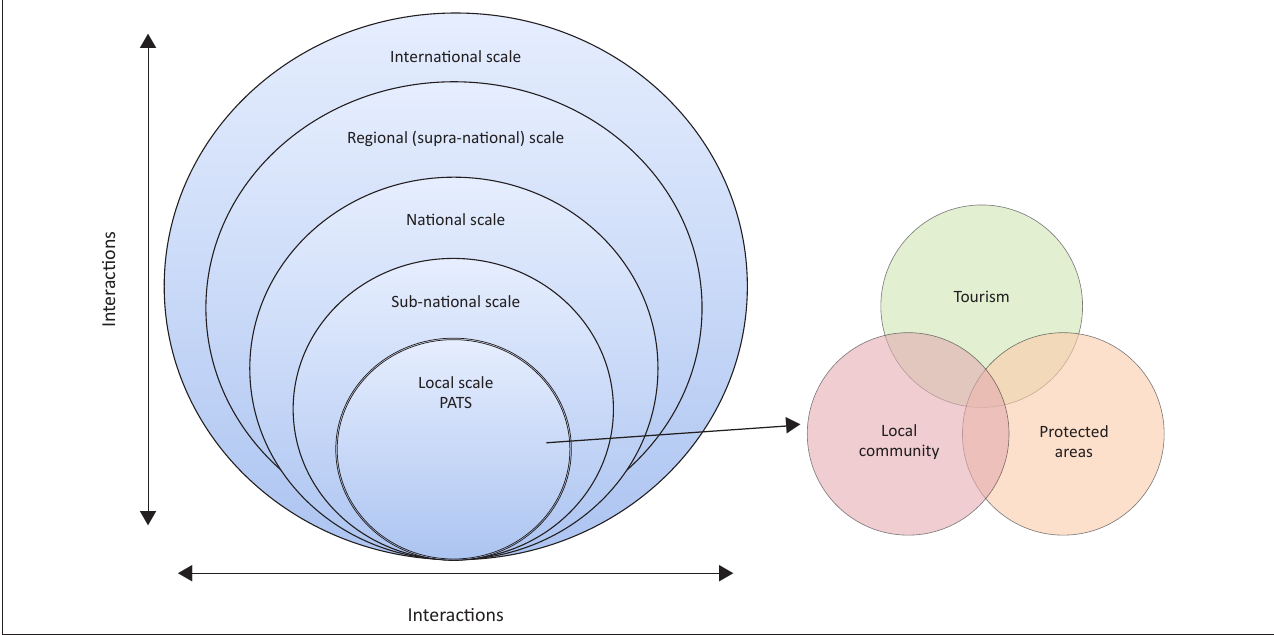
FIGURE 1: Multi-scalar nature of protected area–tourism